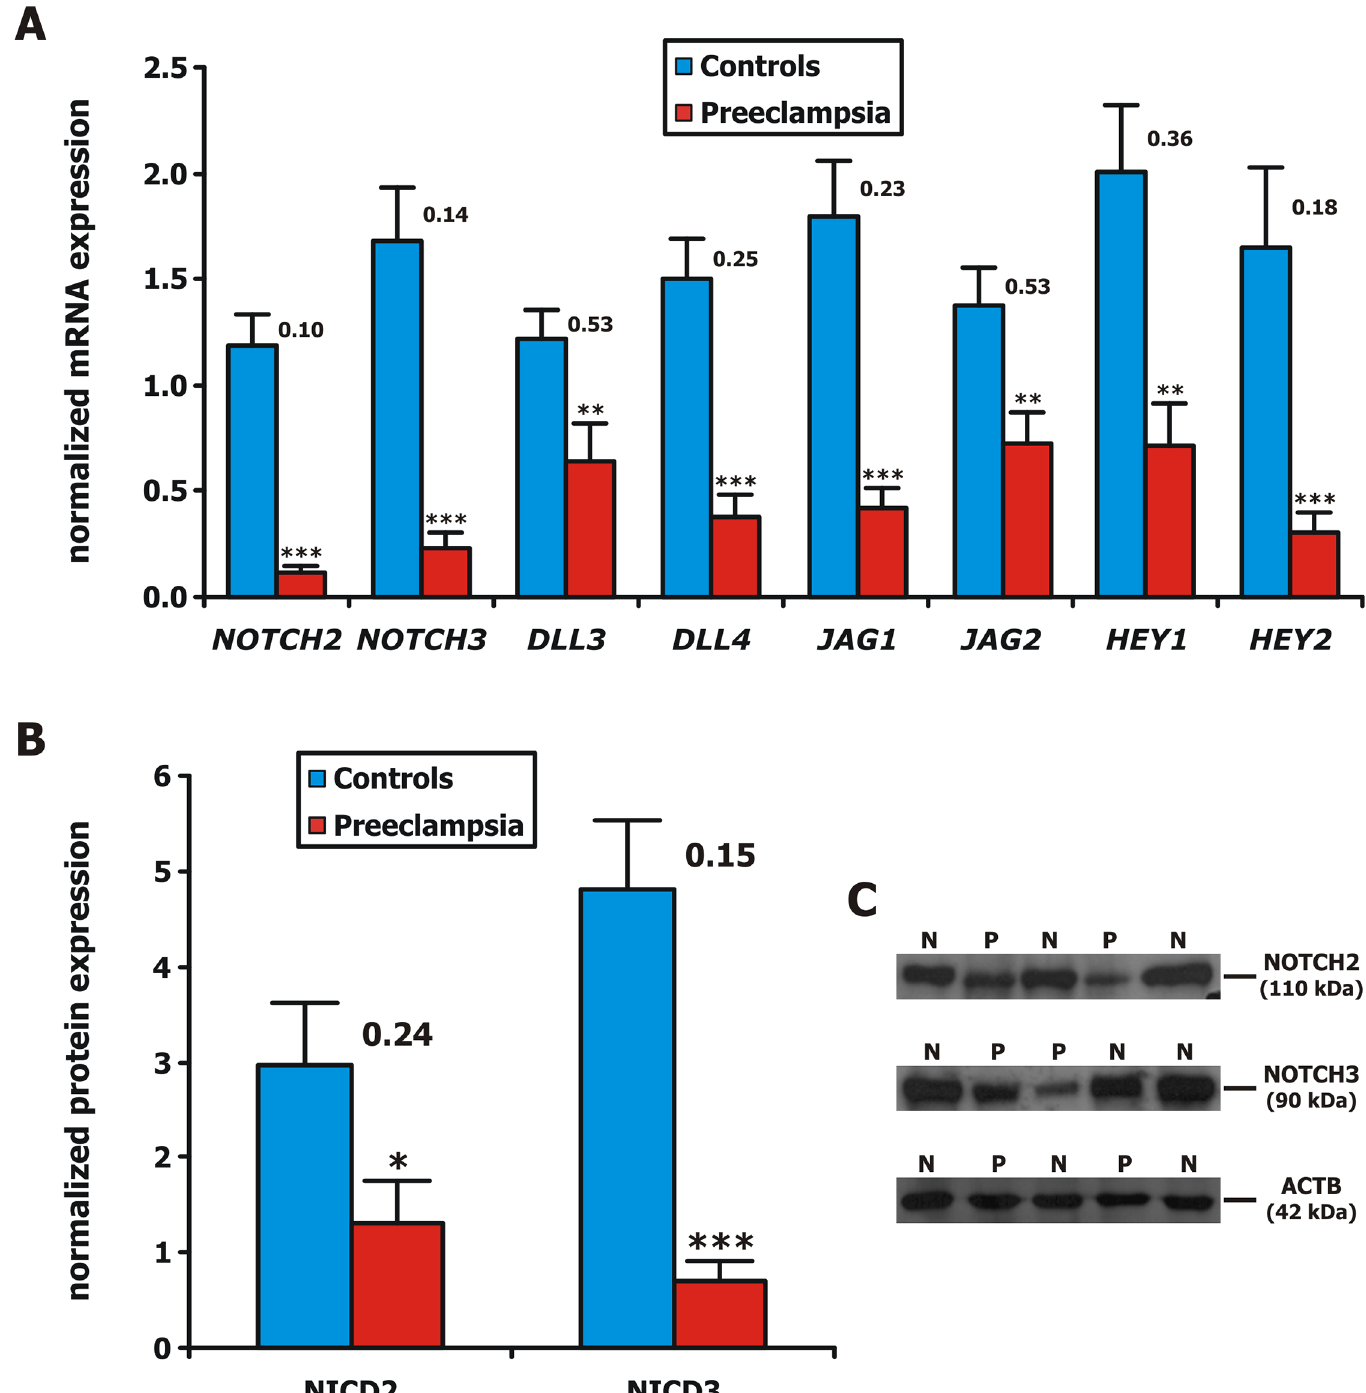
Fig 1. Bar chart depicting Notch pathway members normalized (A) mRNA and (B) protein expression in normal and preeclamptic (PE) late preterm and term placentas, respectively. Floating numbers represent fold change between the two sample groups. Asterisks represent statistically significant associations between PE and controls ( * : p < 0.05; ** : p < 0.01; *** : p < 0.001). Error bars depict standard error of the mean (SEM). (C) Representative Western blots of NICD2 and NICD3 proteins, along with β -Actin (ACTB) housekeeping gene (N: Controls; P: Preeclampsia).